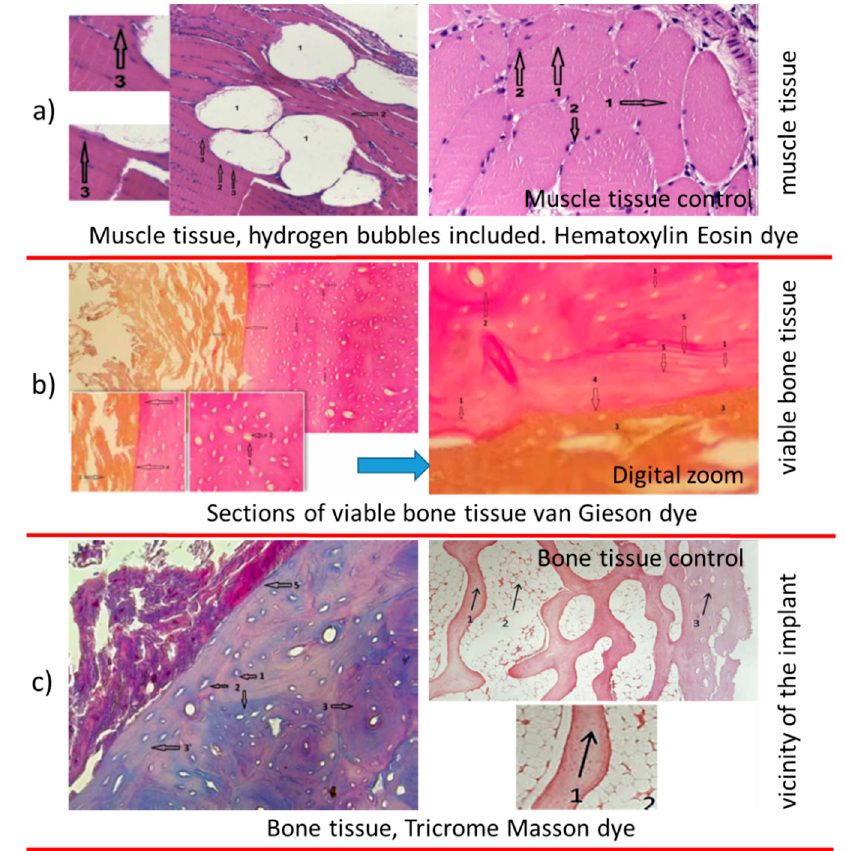
Figure 15. Histological images on different tissue types. a ) muscle tissue; b ) viable bone tissue; c ) bone tissue.